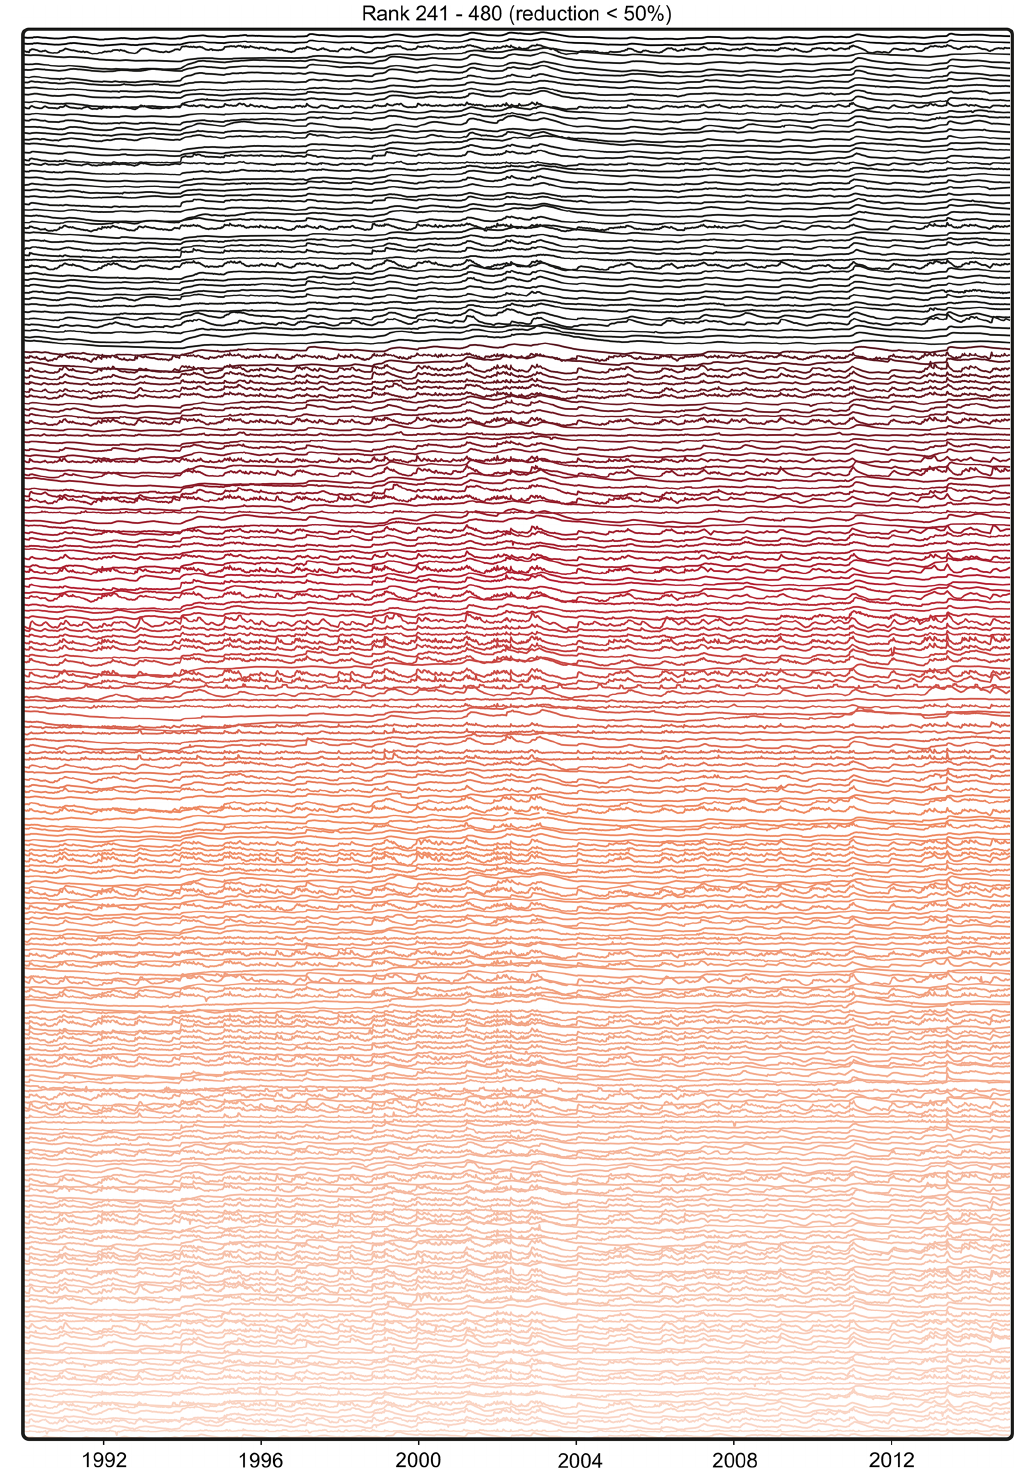
Figure A3. Stacked z -transformed hydrographs of monitoring wells. Rank 241–480.